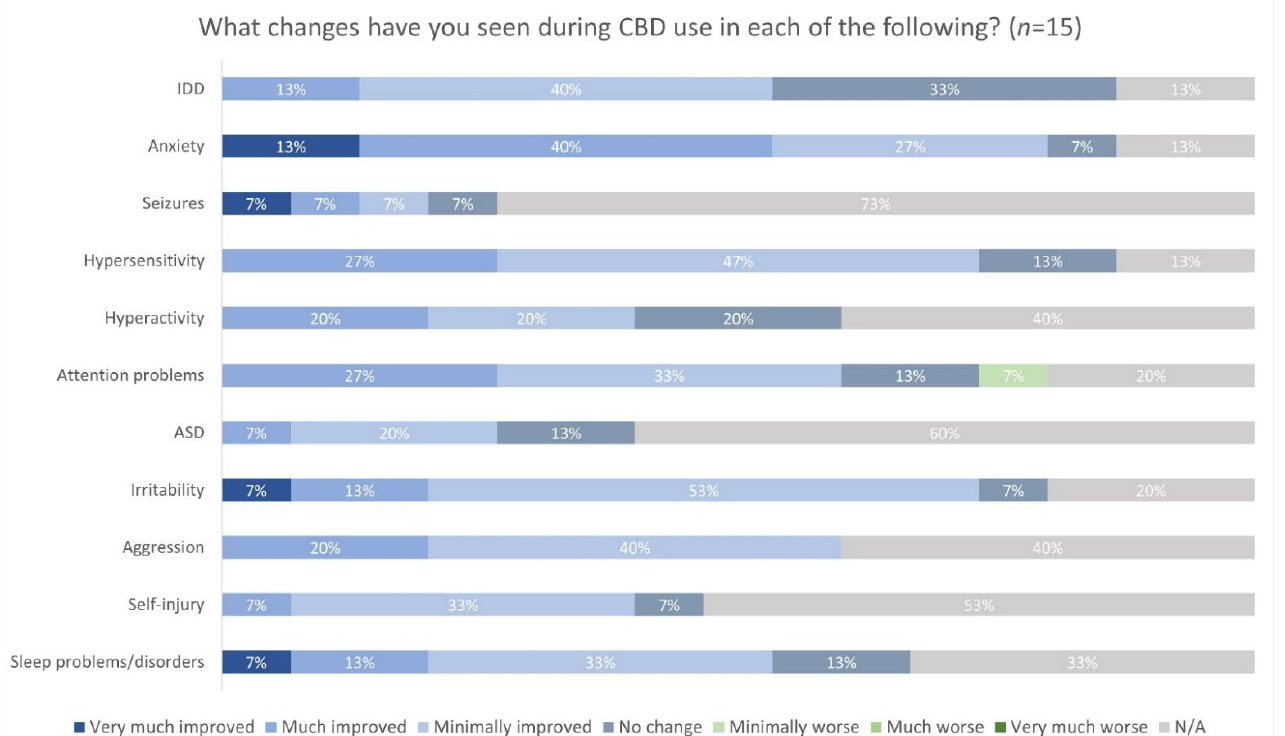
Figure 1. Changes seen with the use of CBD. Footnote: Intellectual Developmental Disability (IDD); Autism Spectrum Disorder (ASD).